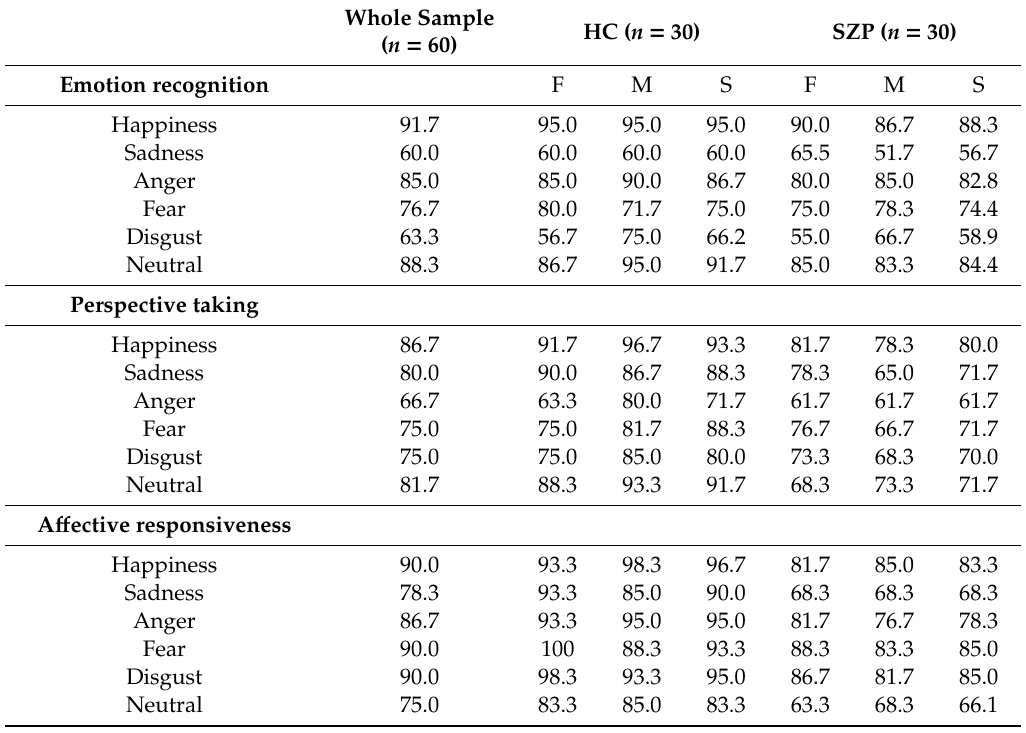
Table 2. Task performance across the whole sample and for the two subgroups, F: female, M: male, S: sum (presented as Mean [SD] in percent